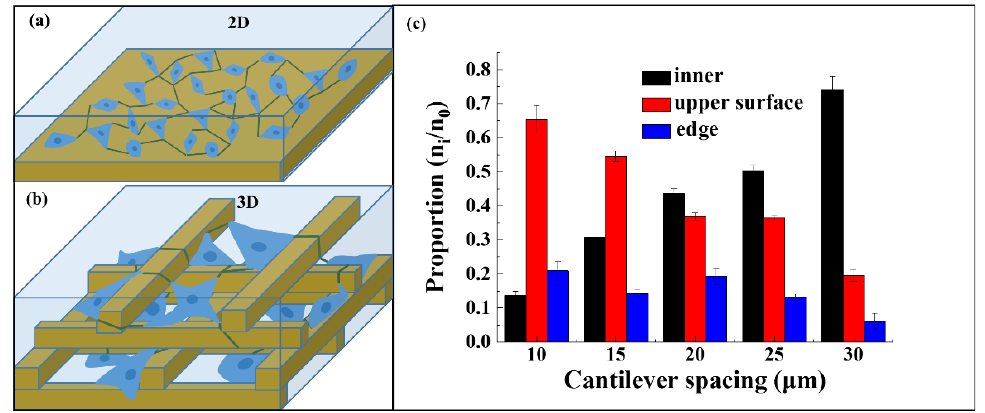
Figure 8. Schematic diagram of 2D ( a ) and 3D ( b ) communication networks. ( c ) Proportion of cells adhering to different positions, such as inner, upper surface, and edge of the 3D microscaffold.